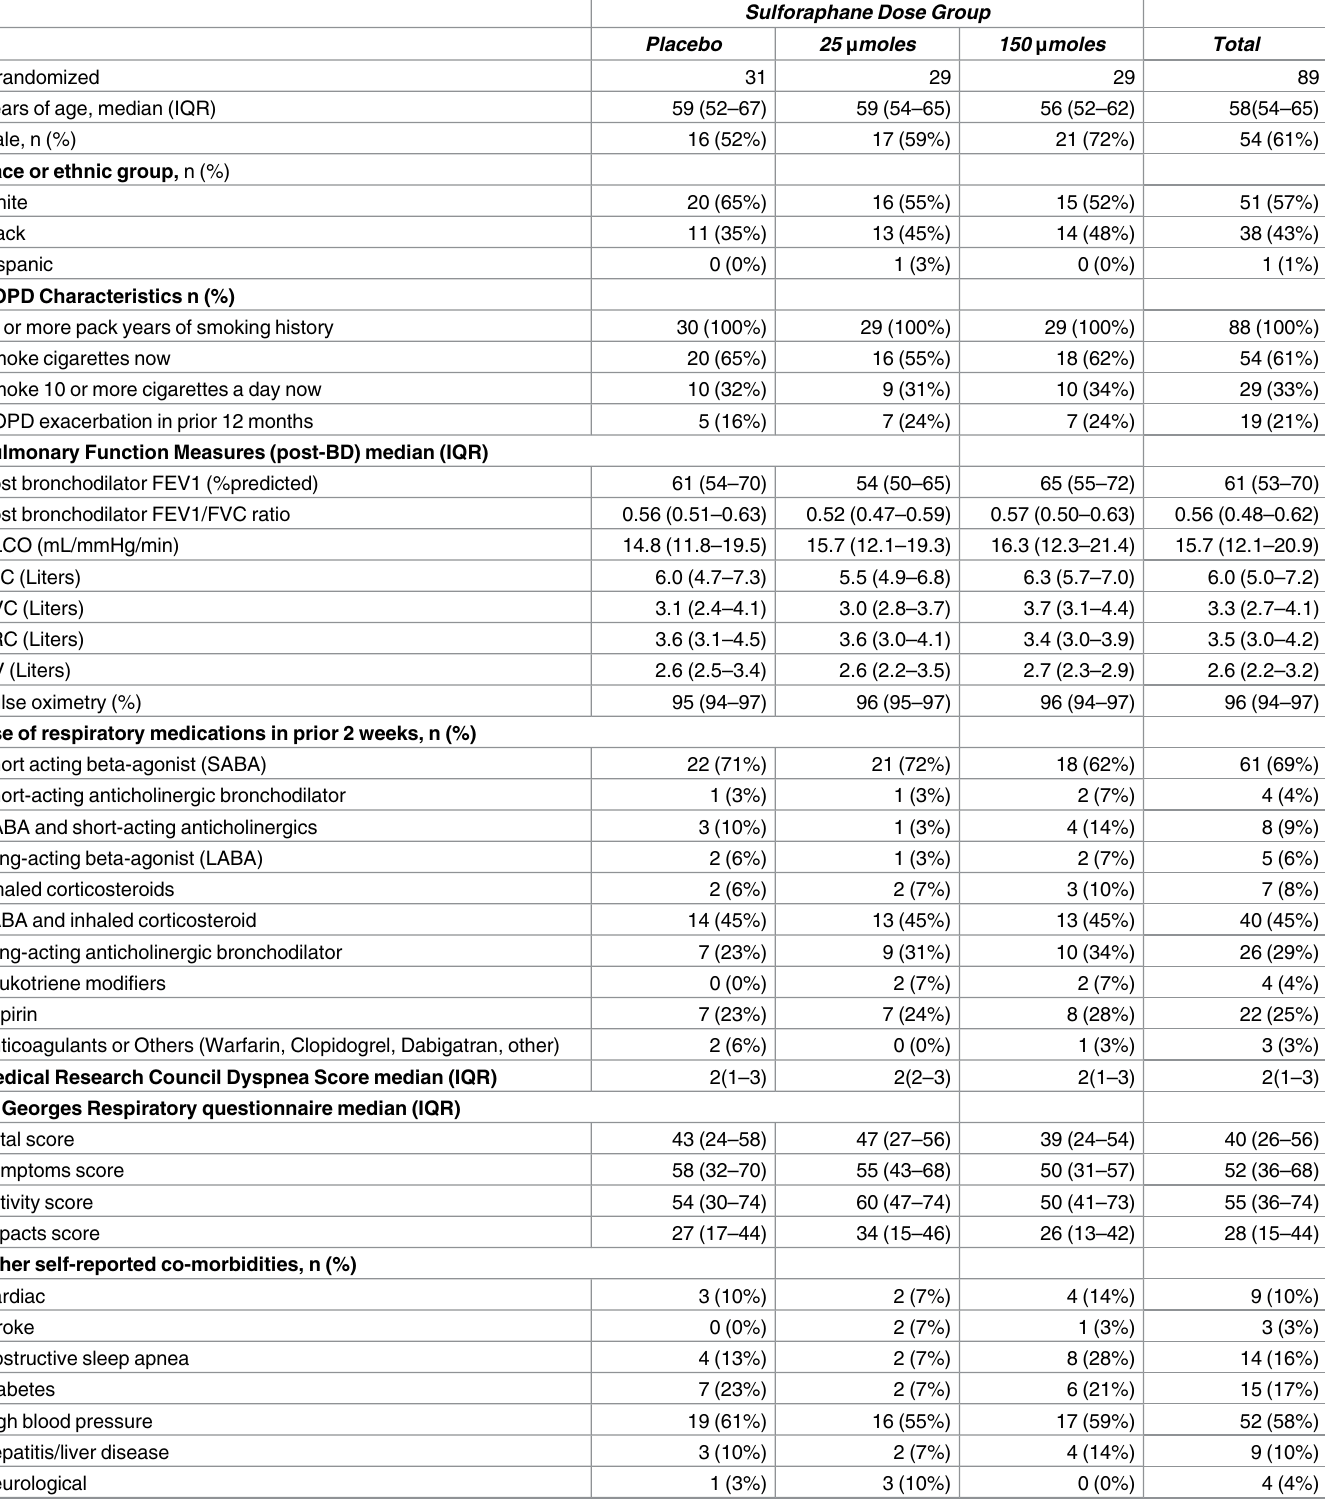
Table 1. Baseline characteristics of randomized participants by treatment